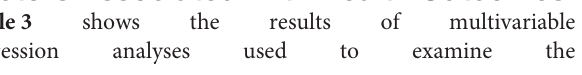
FIGURE 2 | Depression, Anxiety, and Health-related Quality of life by quarantine period (First vs. Second week during the quarantine).